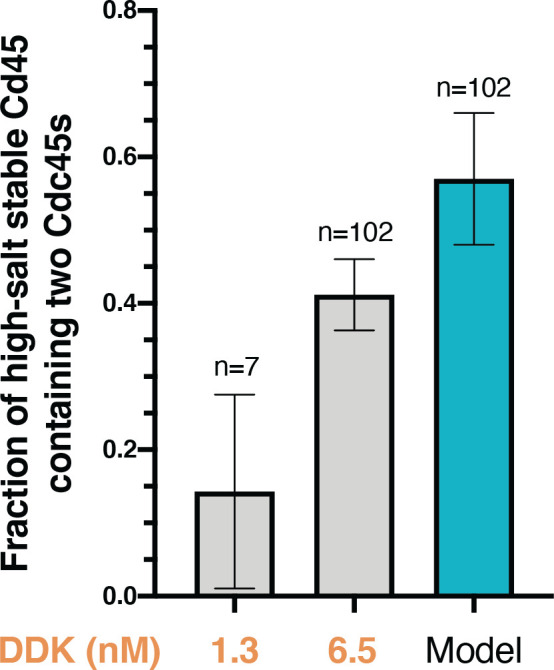
Cdc45-Mcm2-7-GINS (CMG) formation on each Mcm2-7 in the double hexamer can occur independently.The fraction (± SE) of n high-salt-stable Cdc45 SORT649 molecules that contained two Cdc45SORT649 after the HSW2 high-salt wash is plotted for conditions with 1.3 nM and 6.5 nM Dbf4-dependent kinase (gray bars). A model calculating the amount of bound high-salt-resistant Cdc45SORT649 that should include two labeled Cdc45s if CMG formation always occurred on both Mcm2-7 molecules in a double hexamer is shown (teal bar).